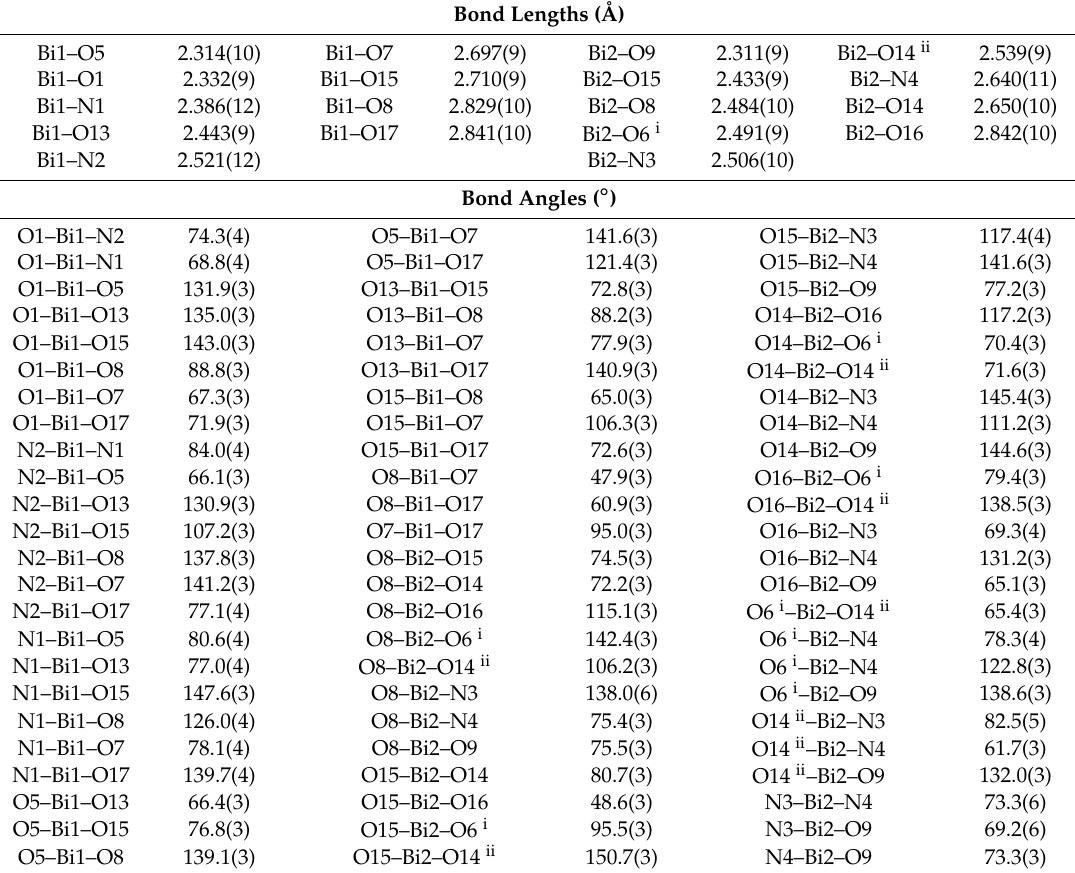
Table 1. Selected bond lengths (Å) and angles ( ◦ ) for complex 1